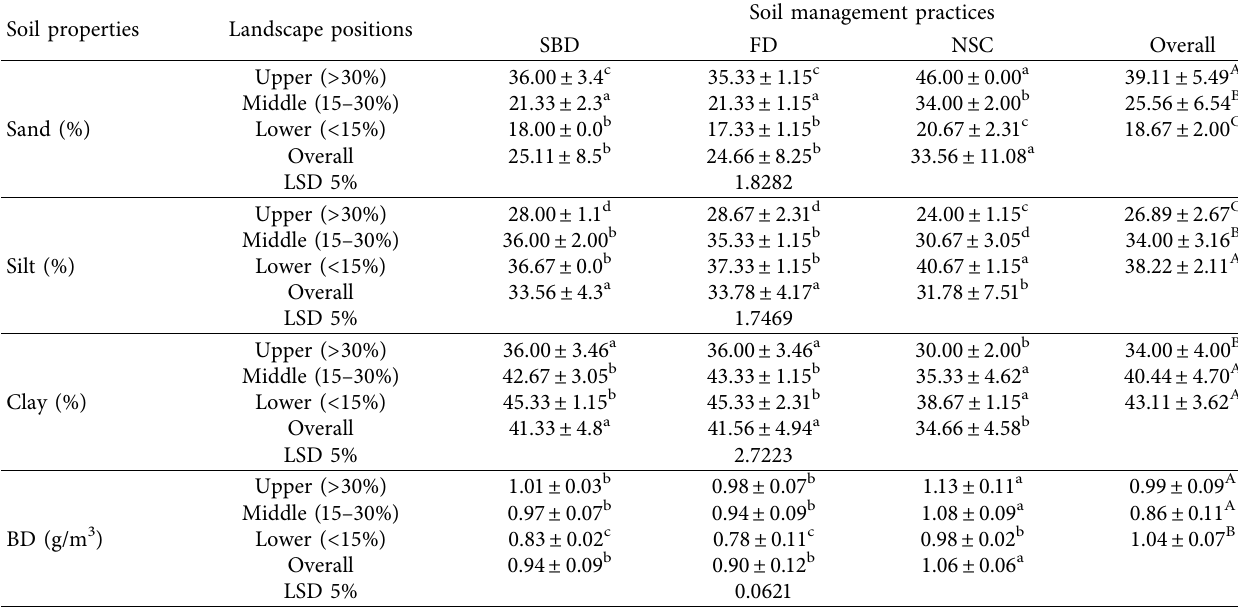
Table 2: Effect of soil management practices at different landscape positions on soil physical